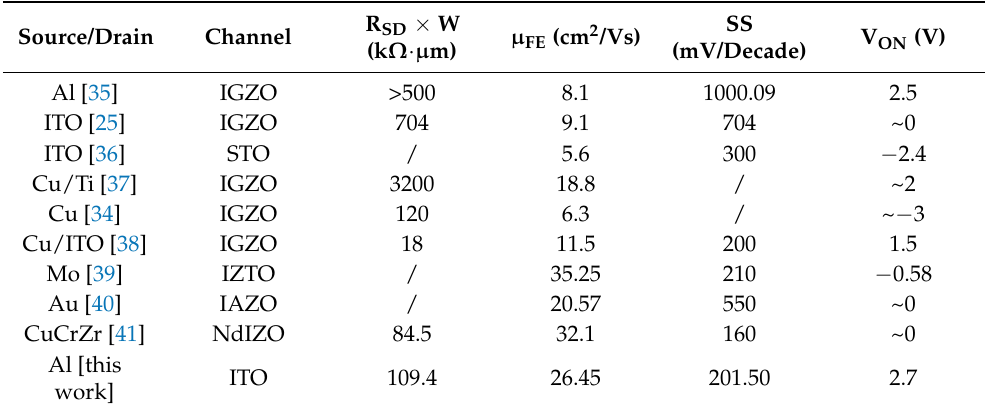
Table 2. Summary of recent reports for major electrical parameters of oxide TFTs with different source/drain